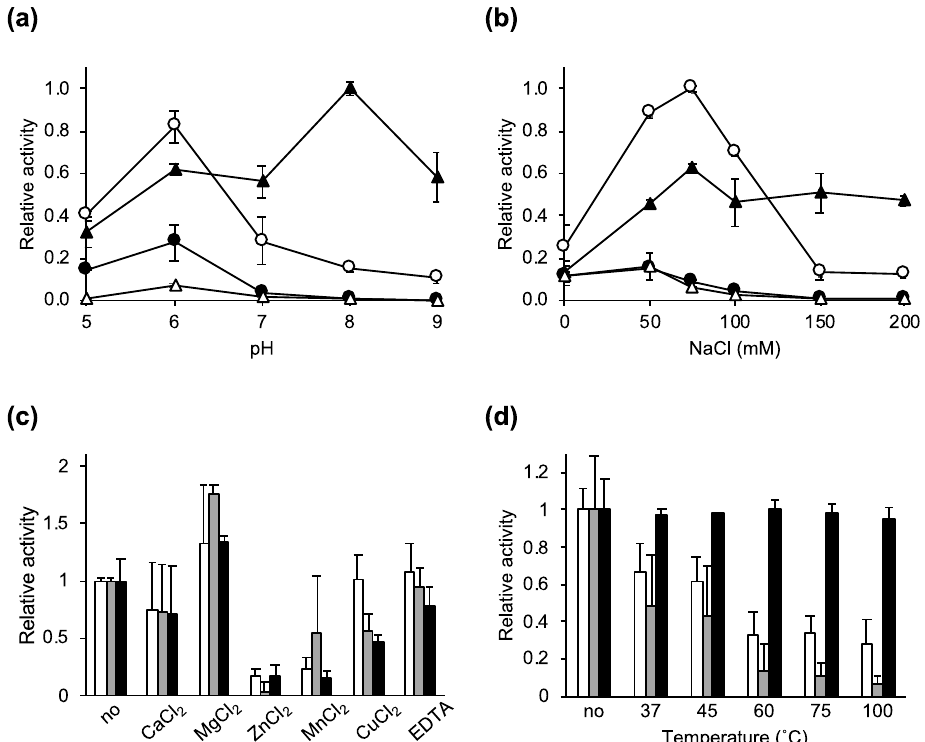
Figure 2. Lytic activity of Ecd09610, Ecd09610CD1, Ecd09610CD3, and Ecd09610CD53 against C. difficile 630 as determined by the turbidity reduction assay. The lytic activity was calculated after 30 min as follows: [ΔOD 600 test (protein added) − ΔOD 600 control (buffer only)]/µmol protein. ( a ) The optimal pH for lytic activity was determined using borate-phosphate universal buffer. The relative activity at pH 6.0 of Ecd09610CD3 was set as 1. ( b ) The effect of NaCl on lytic activity was determined using 25 mM Tris-HCl (pH 7.0). The relative activity at 75 mM NaCl of Ecd09610CD1 was set as 1. Ecd09610 (filled circles), Ecd09610CD1 (open circles), Ecd09610CD3 (filled triangles), and Ecd09610CD53 (open triangles) are shown. ( c ) The effects of divalent metal cations on lytic activity were determined by the addition of 1 mM CaCl 2 , MgCl 2 , ZnCl 2 , MnCl 2 , CuCl 2 , or EDTA. The relative activities are shown with activity in the absence of divalent cations set as 1. The lytic activity with no divalent cations was 35,011 (Ecd09610CD1, white), 16,788 (Ecd09610CD3, gray), and 11,190 (Ecd09610CD53, black). ( d ) The thermal stability of lytic activity was determined by measuring lytic activity after 10 min of heat treatment at 37, 45, 60, 75, or 100 °C, or with no treatment. The relative activities with no treatment for Ecd09610CD1, Ecd09610CD3, and Ecd09610CD53 were set as 1. The lytic activities with no treatment were 104,200 (Ecd09610CD1, white), 62,917 (Ecd09610CD3, gray), and 5288 (Ecd09610CD53, black). Means in all experiments were calculated based on three independent experiments. Standard deviations were calculated by three independent experiments, each with triplicate